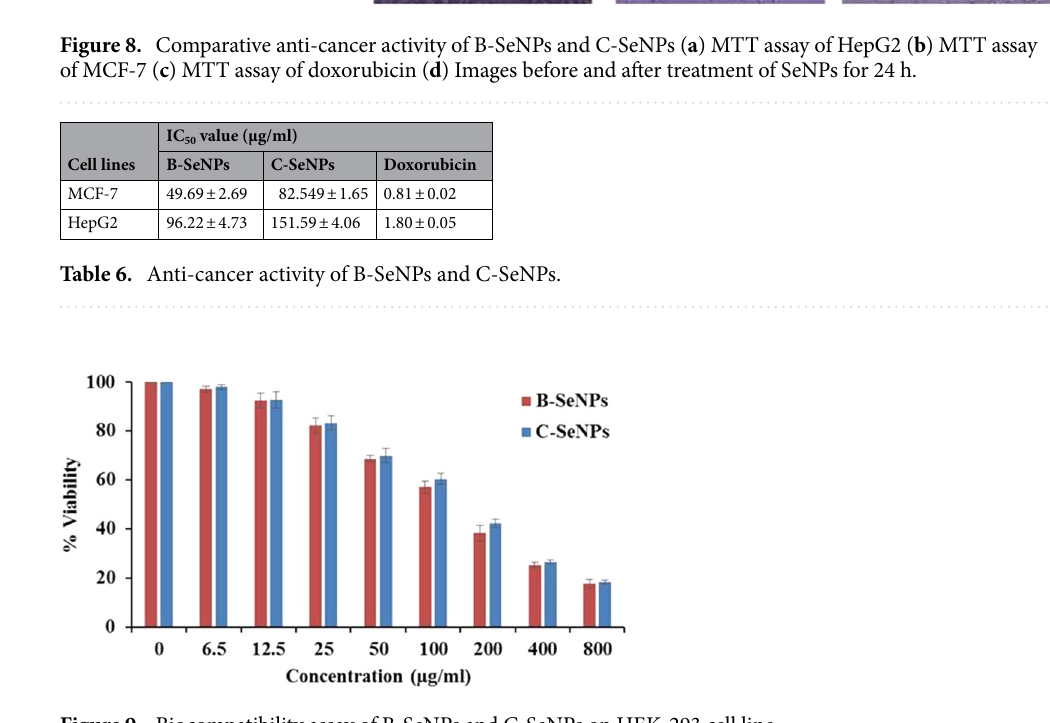
Figure 9. Biocompatibility assay of B-SeNPs and C-SeNPs on HEK-293 cell